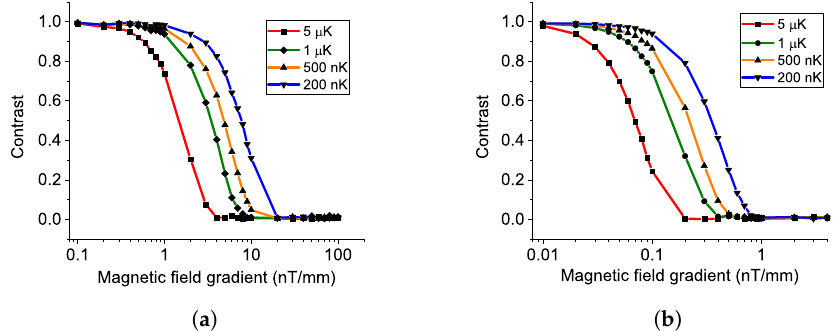
Figure 8. Decrease in fringe contrast by magnetic field gradient and atom temperature in free falling condition, with an evolution time of ( a ) 21 ms and ( b ) 100 ms.